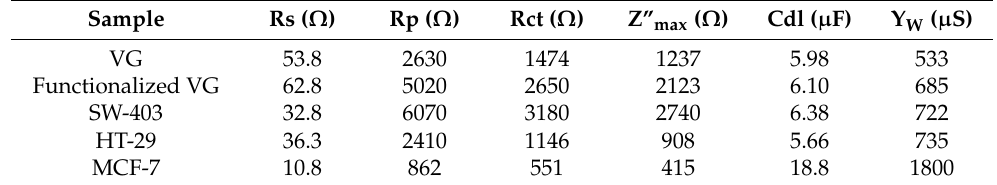
Table 1. Extracted impedance parameters found by fitting the experimentally measured impedance.